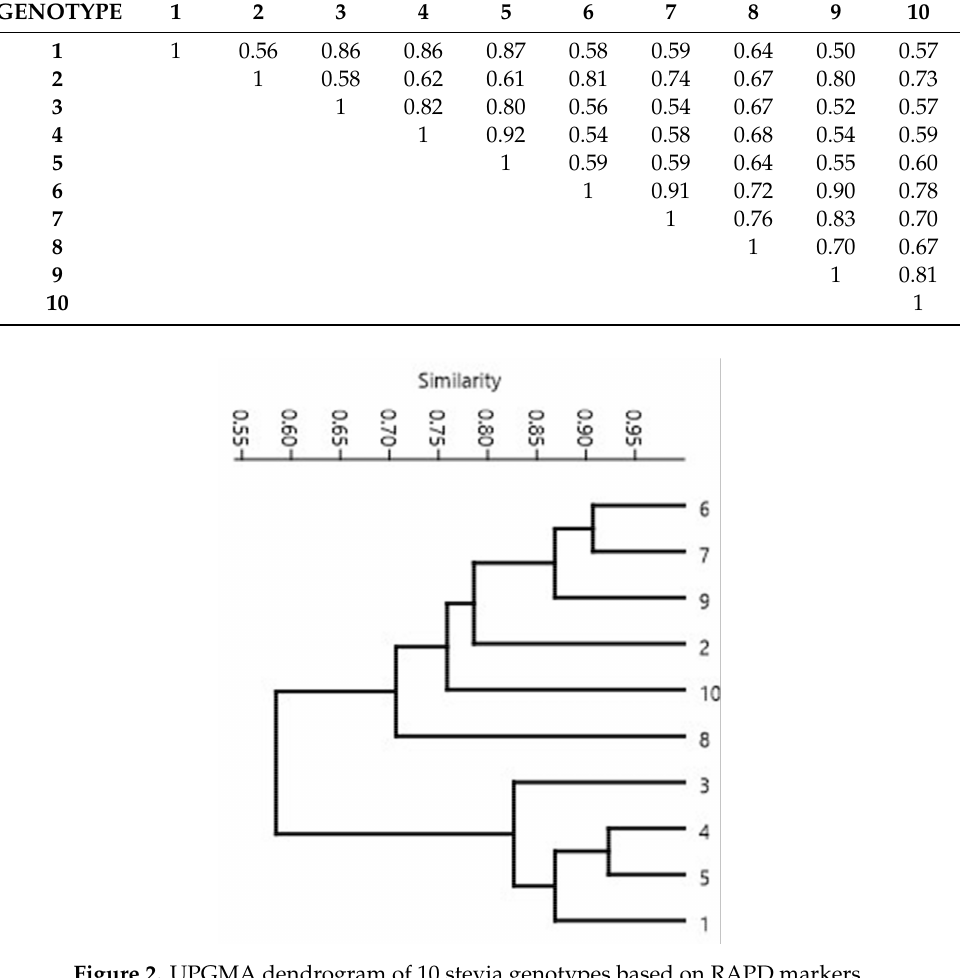
Figure 2. UPGMA dendrogram of 10 stevia genotypes based on RAPD